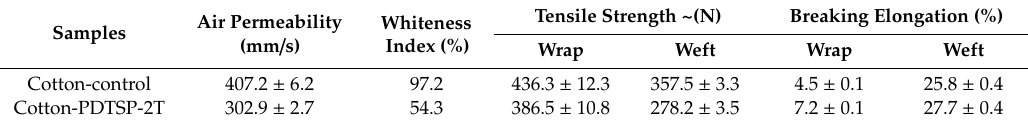
Table 5. Tensile strength, air permeability, and whiteness of Control cotton and Cotton-PDTSP-2T. Tensile Strength ~(N) Breaking Elongation (%) Air Permeability Whiteness Samples (mm / s) Index (%) Wrap Weft Wrap